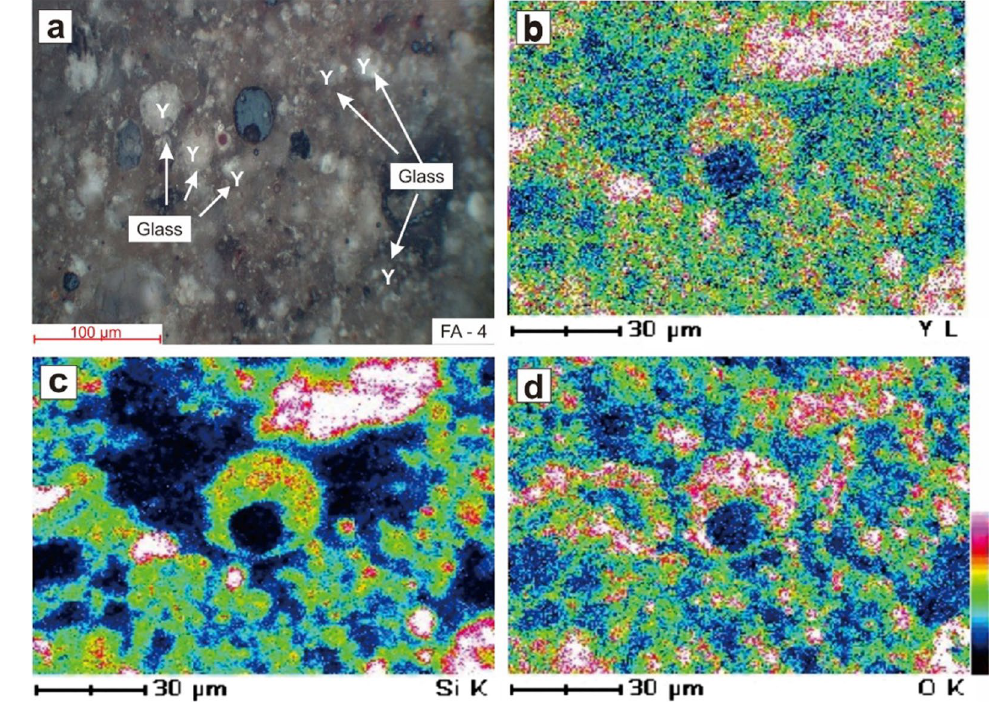
Fig. 13 Mode of occurrence of Y in Glass (sample FA-4). a Optical microscopy of reflected white light; elemental mapping shows the distribu- tion of Y along with the region rich in Si and O